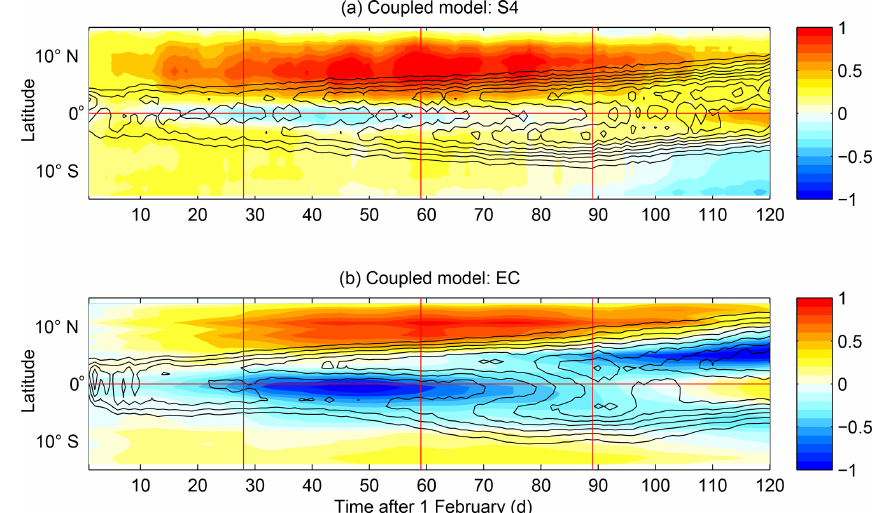
Figure 4. Latitude–time plot, averaged as in Fig. 3, showing biases in sea-surface temperature in the coupled models (filled contours). The rainfall values from the models are shown here as black contours with a 1mmd − 1 interval, starting from 3mmd − 1 . Sea-surface temperature biases are in degrees Celsius ( ◦ C; see colour